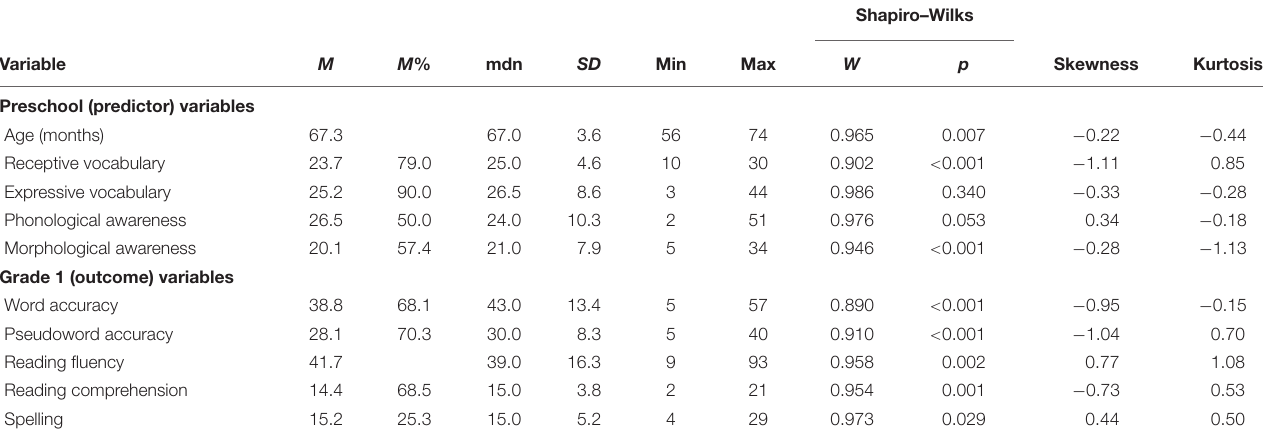
TABLE 1 | Descriptive statistics for predictor and dependent variables.